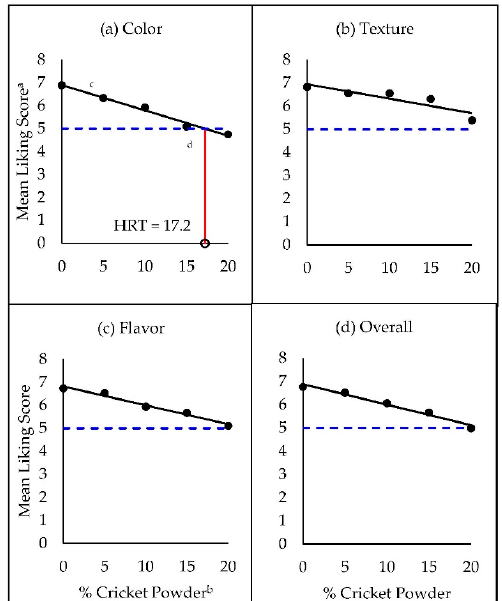
Figure 2. Hedonic rejection thresholds (HRT) for cricket powder in whole-wheat snack crackers. Thresholds were measured based on liking (a 9-point hedonic scale) of ( a ) color, ( b ) texture, ( c ) flavor, and ( d ) overall liking. a Mean liking scores from a 9-point hedonic scale. b Percentage of cricket powder used in place of whole-wheat flour ( w/w ) in cracker formulations. c Black solid line represents a simple linear regression of liking scores (y) as a function of % cricket powder (x), and black dots represent observed mean liking scores for each treatment. d Vertical red line represents the HRT, which was interpolated as the % cricket powder associated with a predicted hedonic score of 5 (blue horizontal dashed line) from the simple linear regression (not found for texture, flavor, or overall liking).